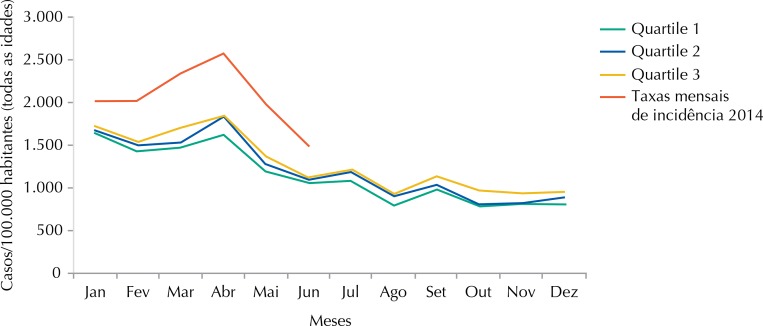
Canal endêmico 2009-2013 (todas as idades) pelo método dos quartis e taxas de incidência mensais registadas em 2014 (todas as idades), Moçambique.